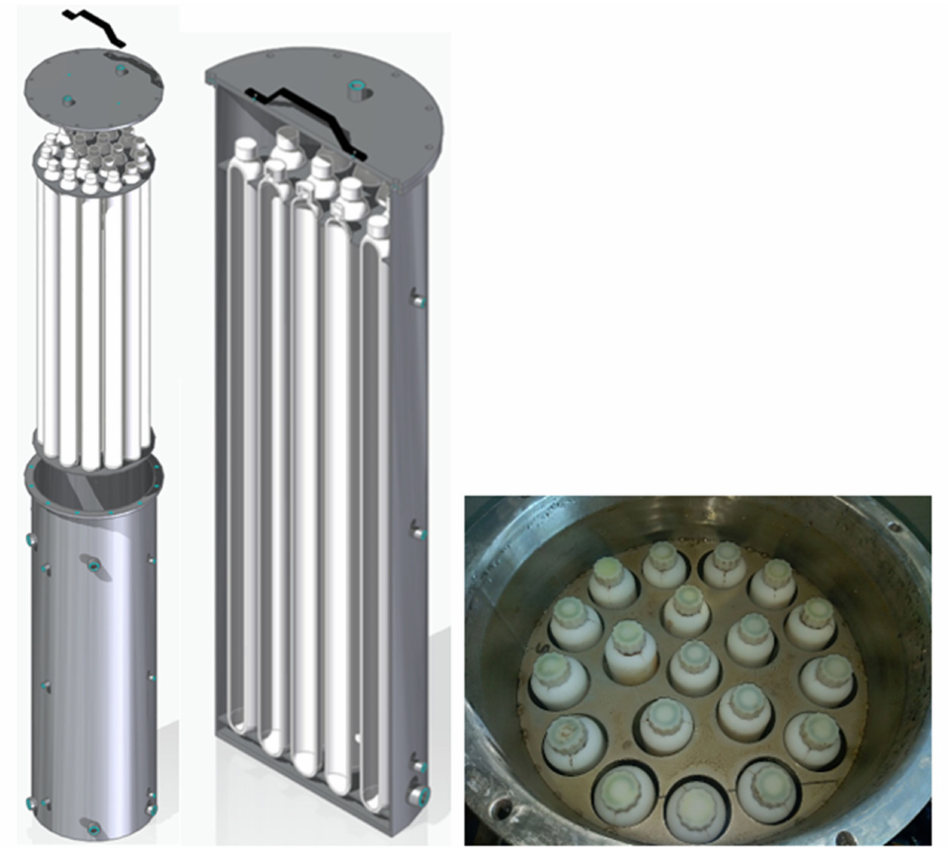
Figure 3. Detailed exploded tri-dimensional view of the designed hybrid sensible/latent storage, left-hand side, section of the internal macro-capsules’ arrangement, center, and view of the capsules inserted inside the storage, right-hand